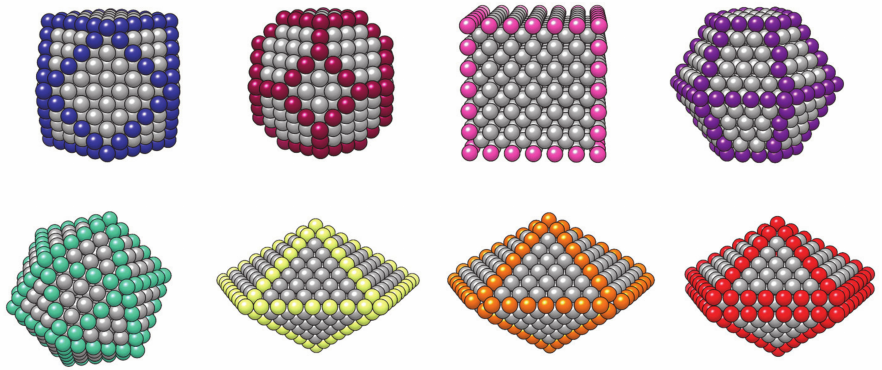
Figure 11. Models of crystalline NPs (left to right: fcc—cuboctahedron and truncated octahedron, bcc, and hcp) in top panel and noncrystalline NPs (left to right: icosahedron, regular, Marks, and Ino decahedron) in bottom